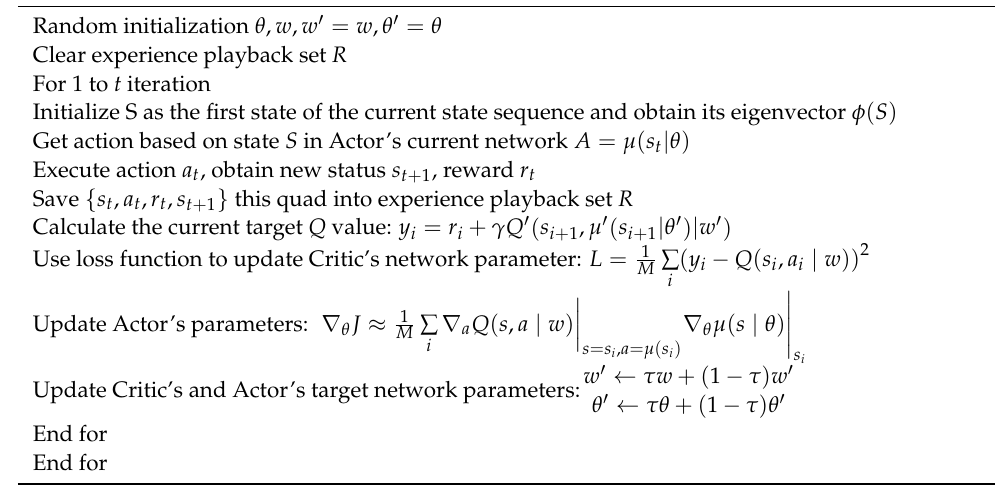
Algorithm 1: DDPG algorithm pseudo-code.